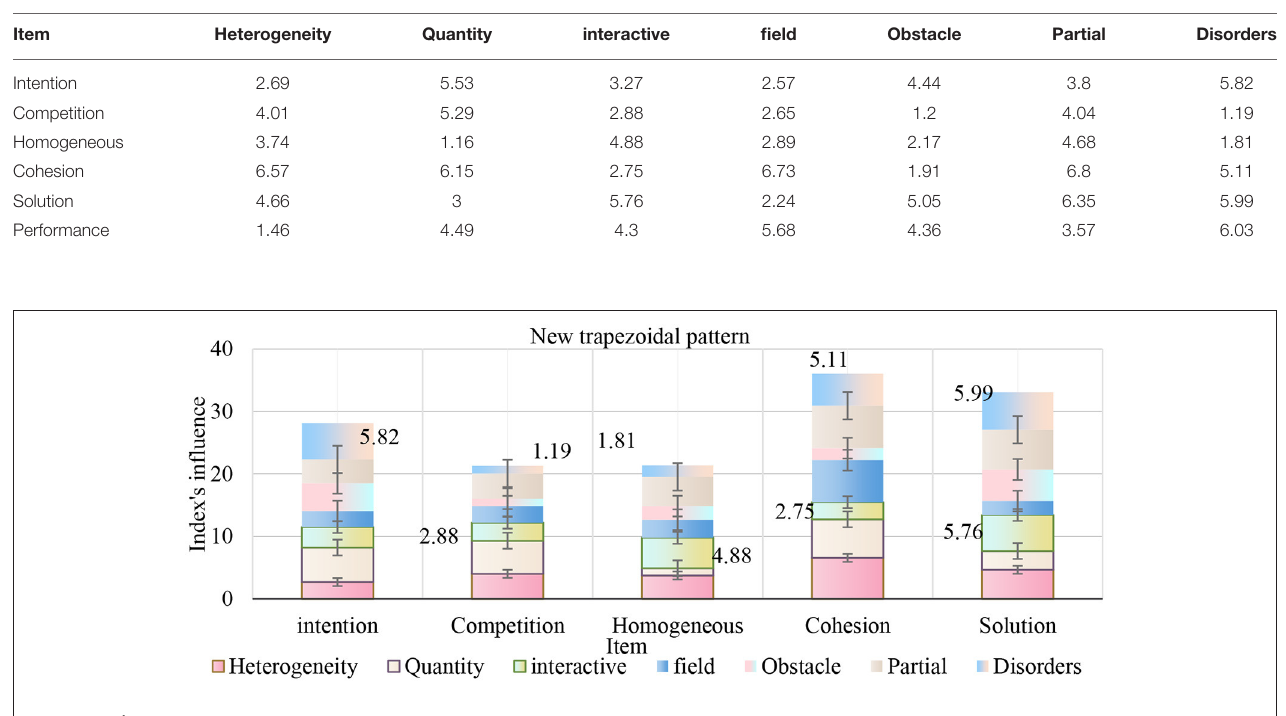
FIGURE 12 | New trapezoidal